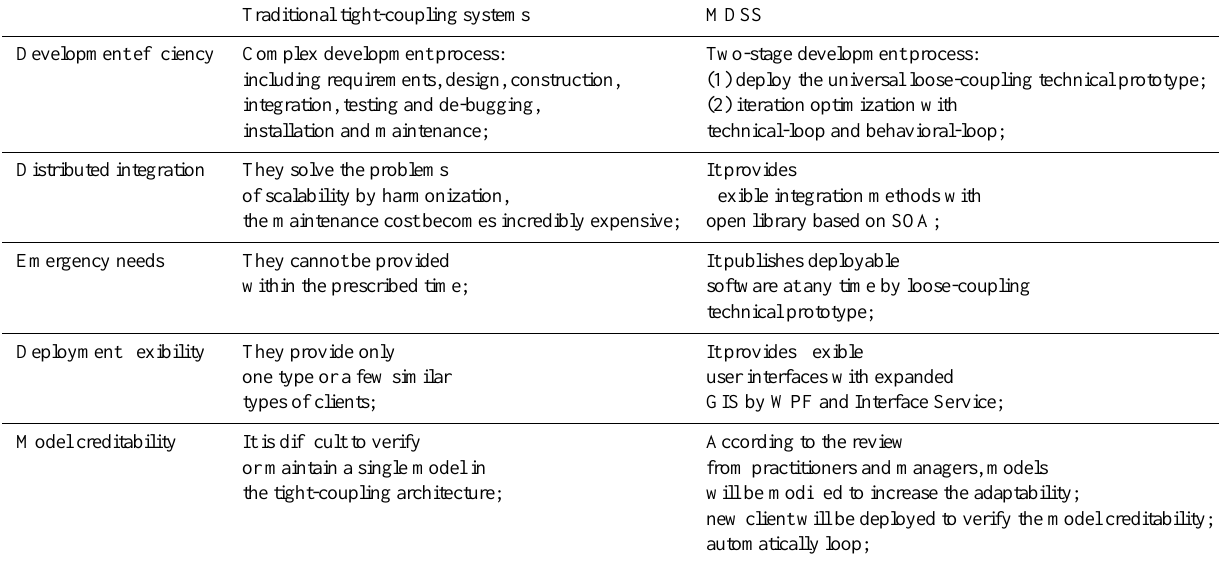
Table 4. Comparison between traditional tight-coupling systems ∗ and